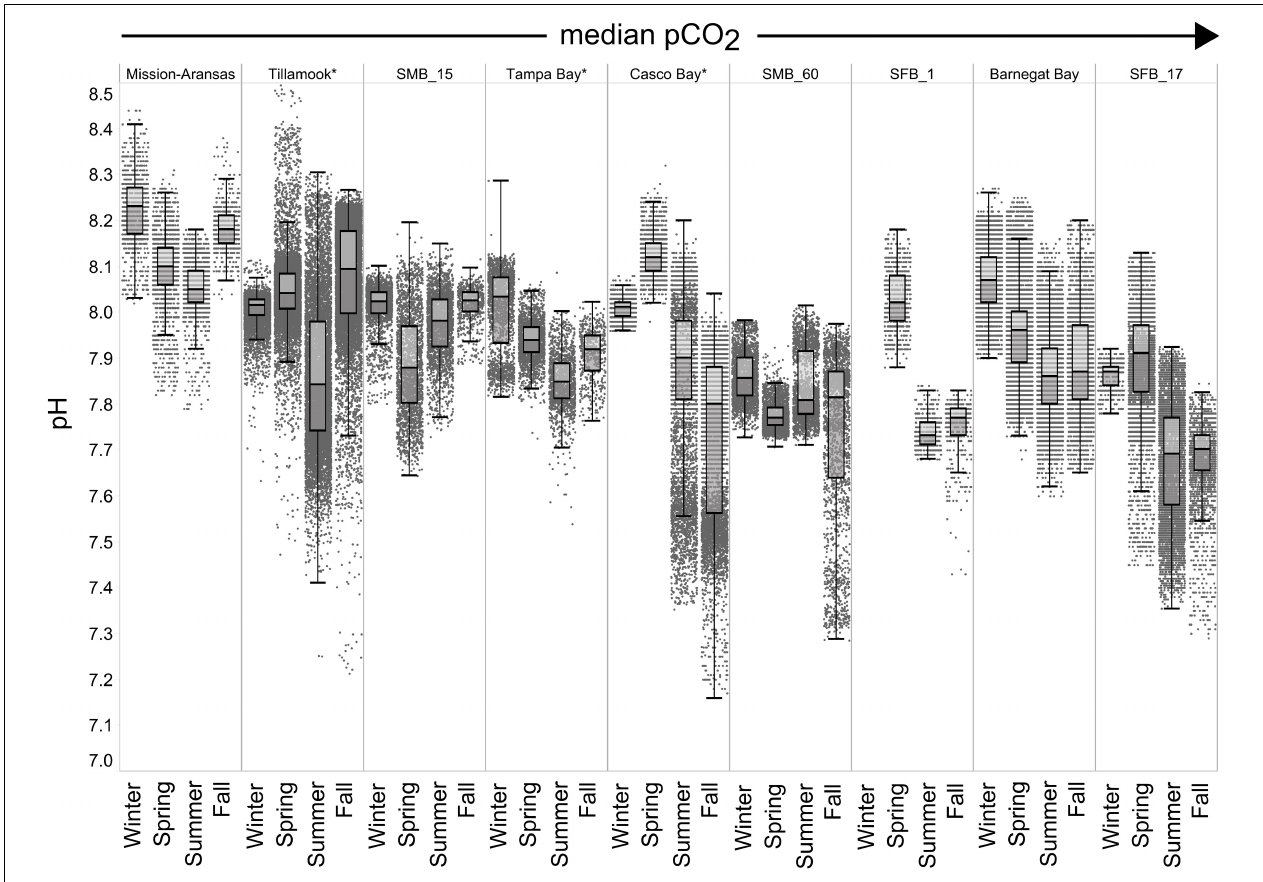
FIGURE 7 | Box plots and underlying data showing the seasonal distribution of pH data across the seven water bodies. The water bodies are arranged from lowest median partial pressure of carbon dioxide ( p CO 2 ) to highest median p CO 2 . Whiskers extend to data within 1.5 times the interquartile range (IQR).